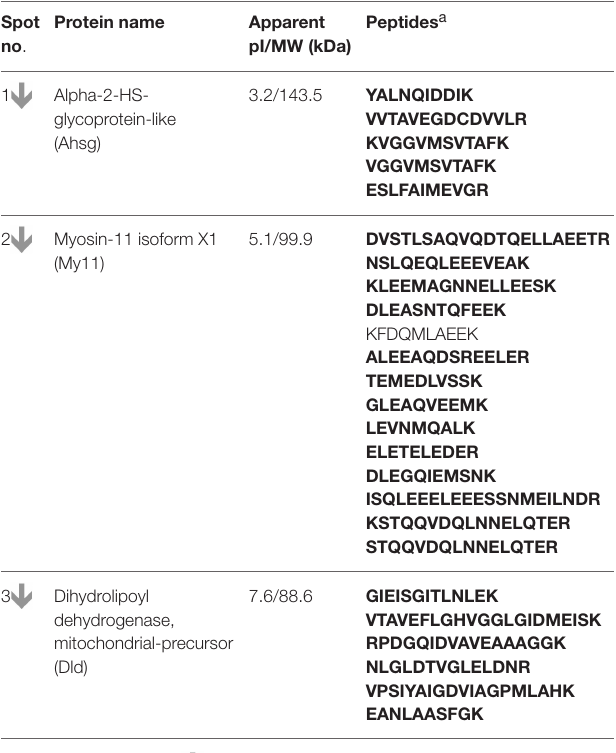
TABLE 6 | Information of the proteins that were differentially expressed in the distal intestine of Atlantic salmon from different groups. Spot no